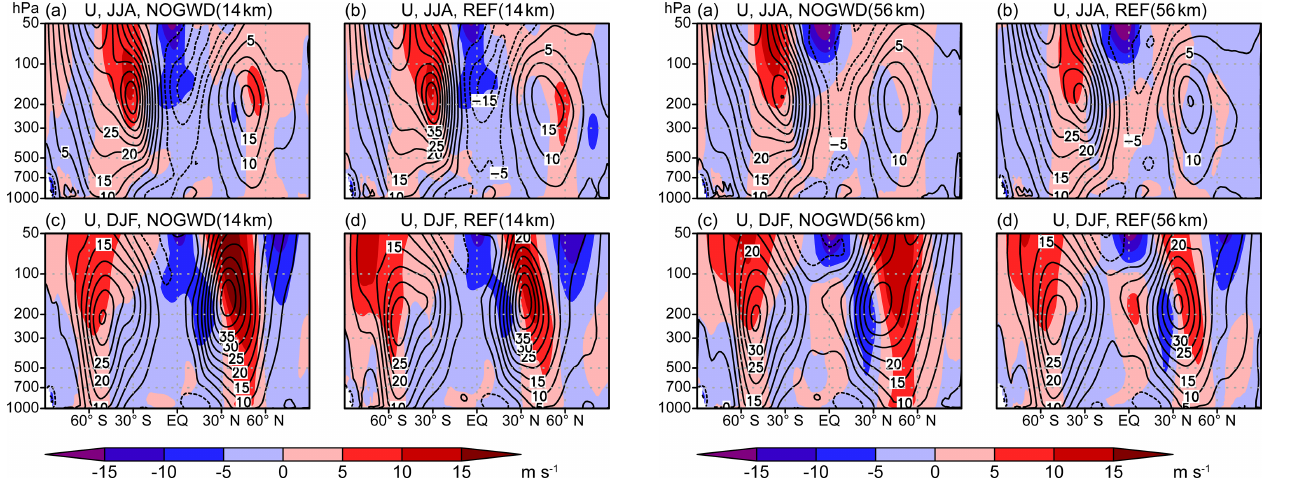
Figure 15. Same as Fig. 14 but for the simulation by